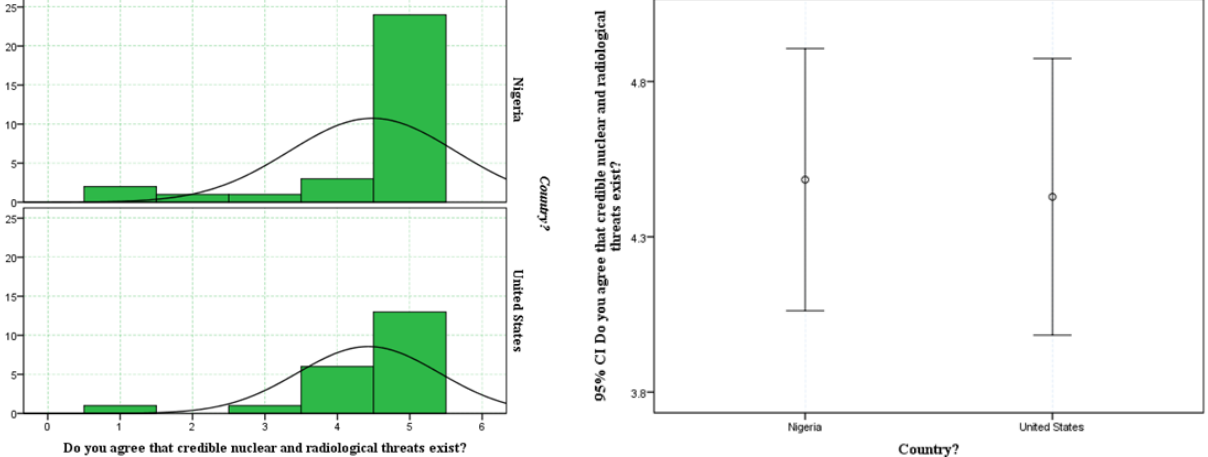
Figure 6. Existence of credible nuclear and radiological threats